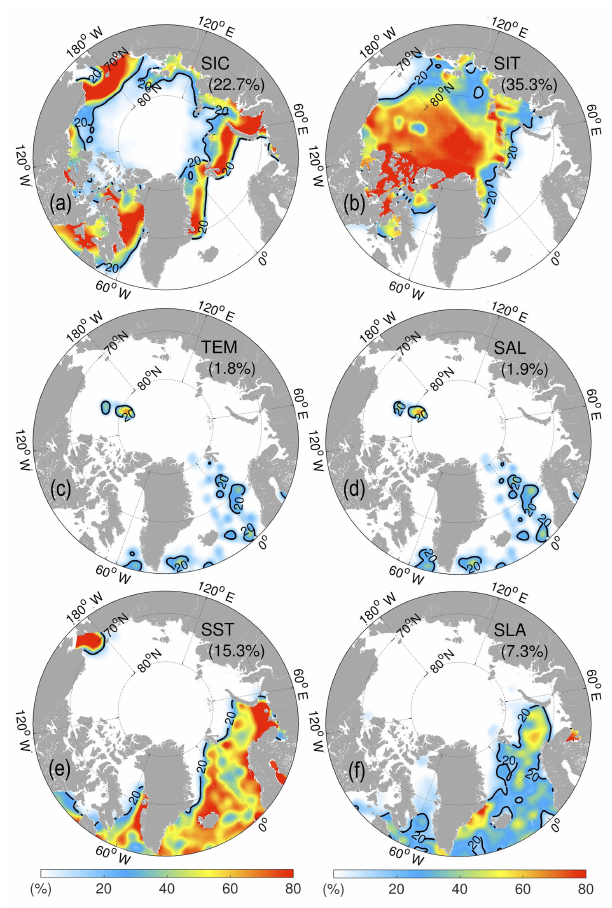
Figure 13. Relative DFS contributions (IF) of each observation data types in November 2014. (a) SIC from OSI-SAF; (b) SIT from CS2SMOS; (c) temperature profiles; (d) salinity profiles; (e) SST; (f) along-track sea level anomaly (SLA). The black line is the 20% isoline, and the monthly IF (see Eq. 12) is reported between paren- theses.